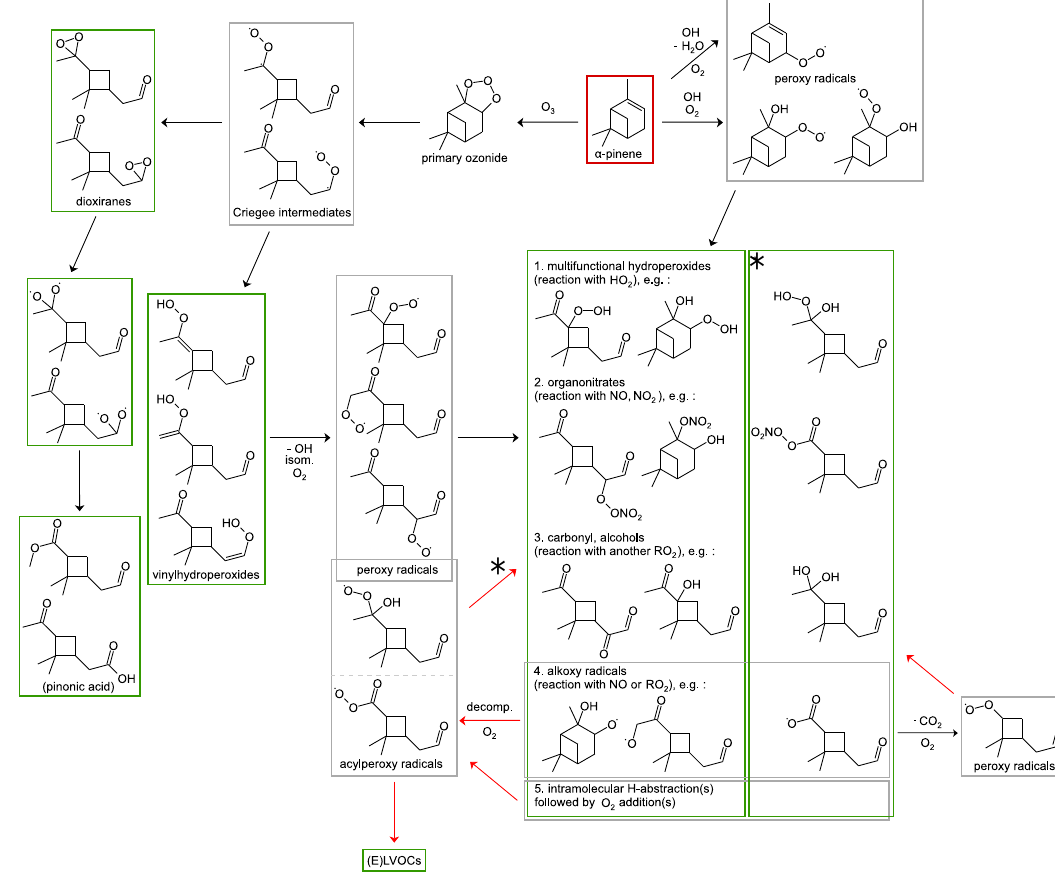
Figure 1. Non-exhaustive summary of α -pinene ozonolysis (left) and OH oxidation (right) reaction pathways. Oxidation by NO 3 has been left out for the sake of clarity and because it is not relevant to the present study. Not all possible reaction pathways and final products are displayed but only representative examples. Products (either stable or intermediates) have been grouped in boxes to indicate that several products may arise from the same reaction. The green box marked with a star (*) corresponds to products formed from (acyl)peroxy radicals (red arrow marked with a star). See main text and discussion for